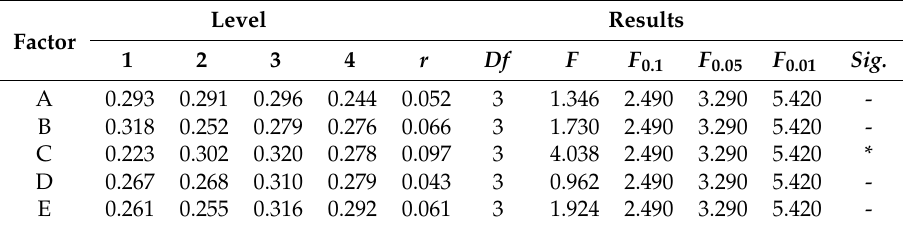
Table 8. Analysis of the influencing factors on the flexural–compressive ratio.